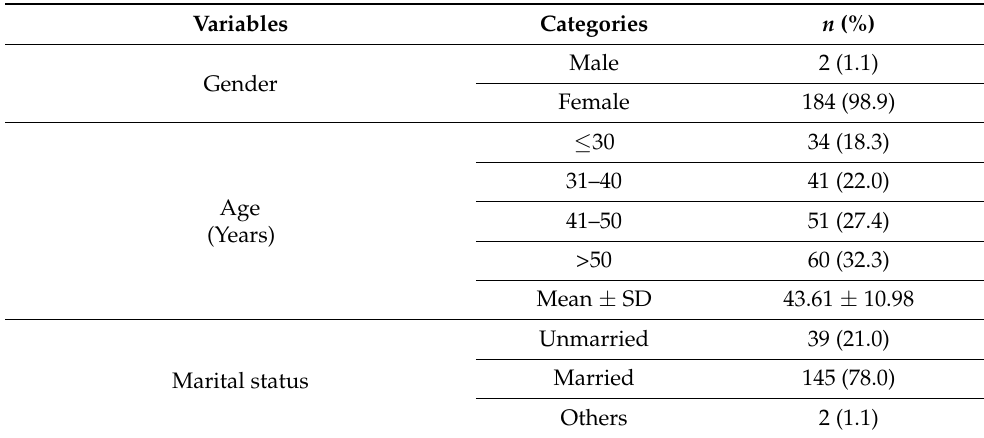
Table 1. General characteristics of the participants ( N =